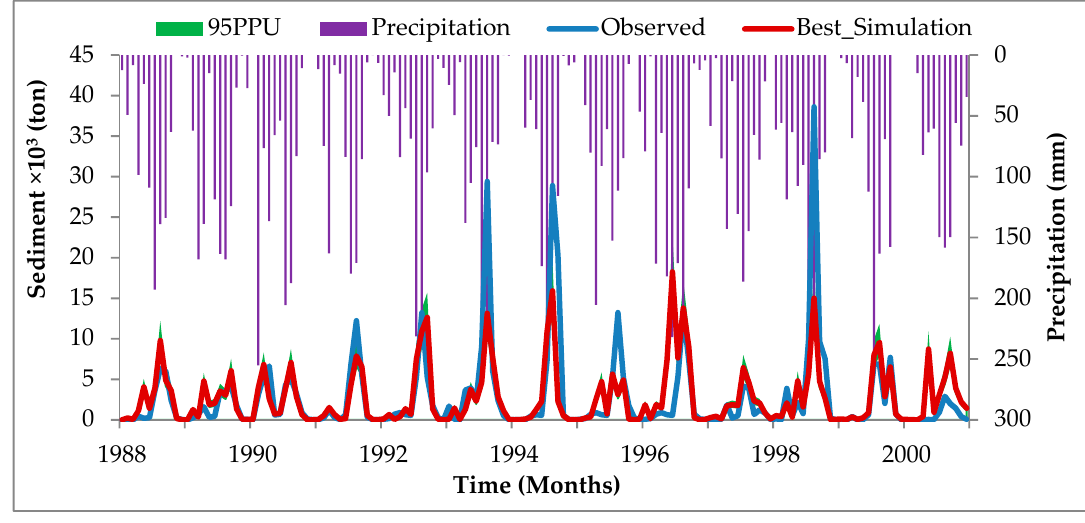
Figure 4. Sediment yield calibration for the Meki River.